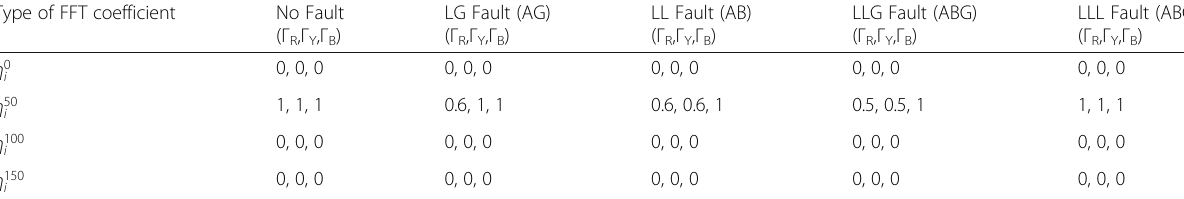
Table 1 NVCs for phase discrimination in the test system shown in Fig. 1 Type of FFT coefficient